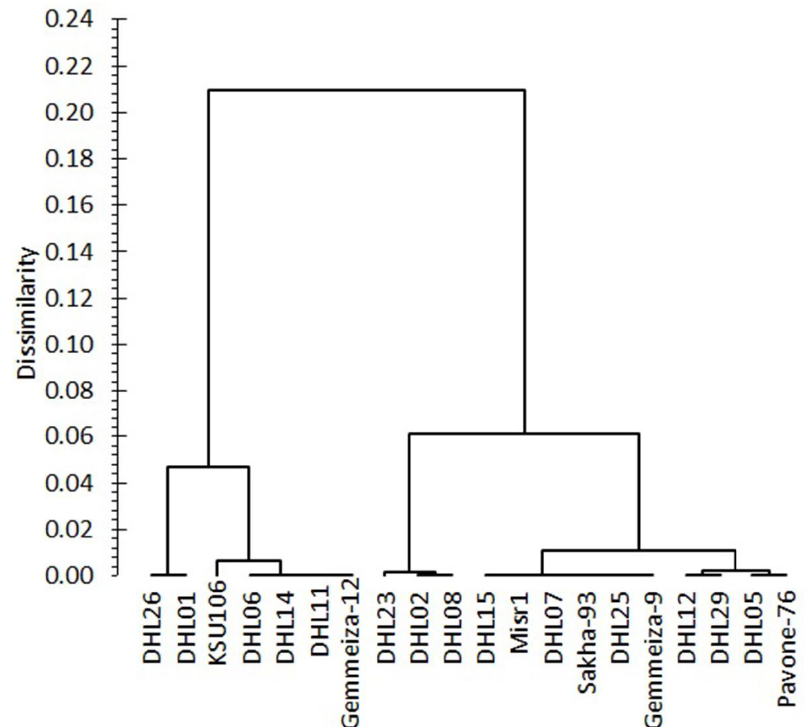
Figure 2. Dendrogram showing clustering of 20 wheat genotypes based on the Euclidean distance of the (D) value.